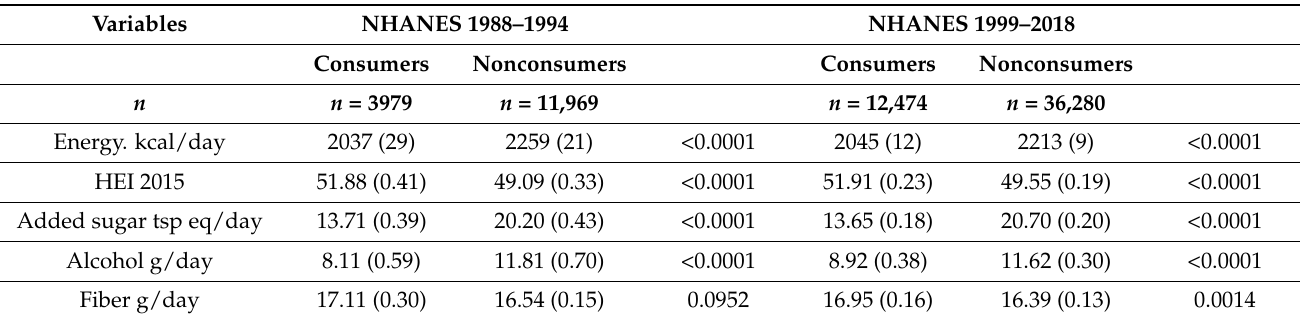
Table 4. LCS consumers and non-consumers by dietary and health variables. Data are means (standard error, SE). Data adjusted for complex sample design of NHANES and used relevant sample weights.